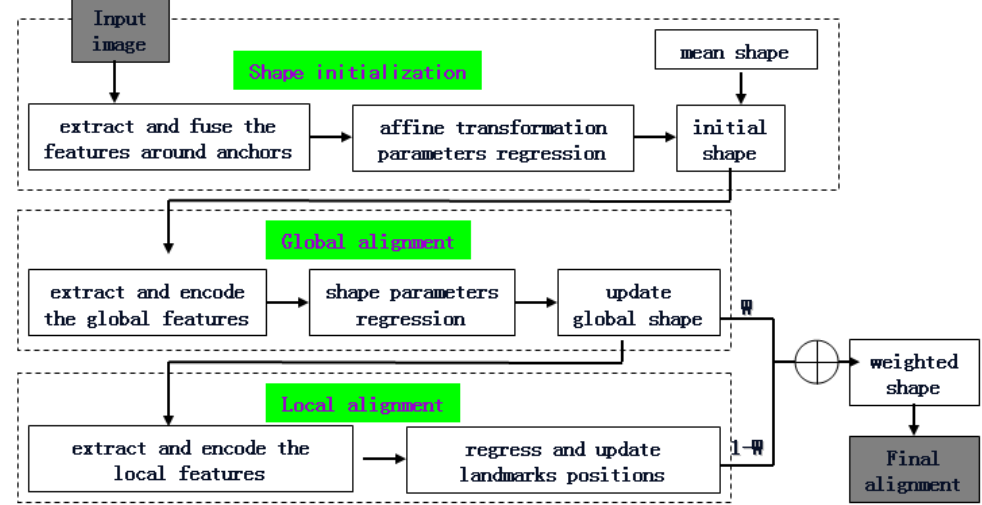
Figure 1. Overview of the proposed alignment framework.